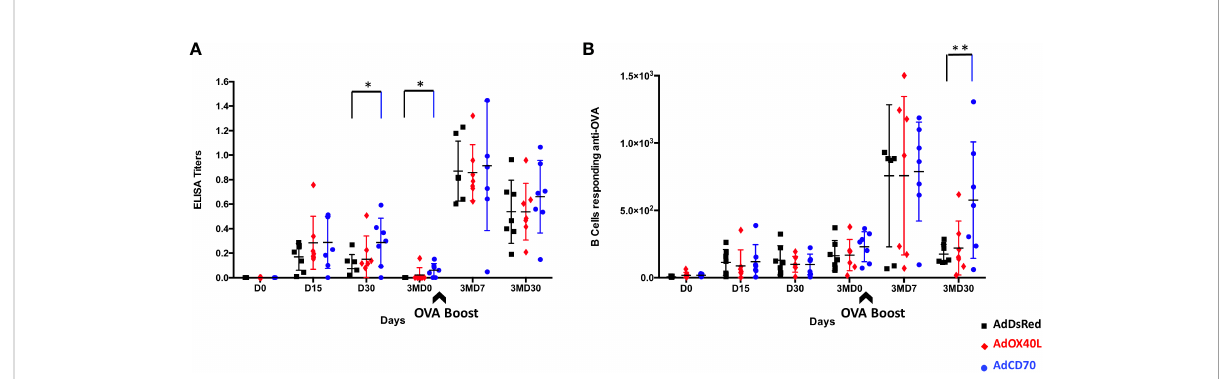
FIGURE 3 OVA speci fi c antibodies production in inoculated sheep. (A) Detection of anti-OVA-speci fi c antibodies by ELISA assay. Inoculation with OVA concomitantly with recombinant adenovirus expressing the Oa OX40L or Oa CD70 proteins induces OVA-speci fi c IgG in sheep. Groups (n = 7) of sheep were inoculated intramuscularly with OVA simultaneously with control vector AdDsRed (black), AdOX40L (red), or AdCD70 (blue), respectively, at day 0; and 3 months later (3MD0) boosted only with OVA (indicated by the arrow). At the indicated time points, the serum samples obtained were analyzed for OVA-speci fi c IgG by ELISA using OVA-coated plates. Data are presented as OD read at 450nm IgG titer for each animal. *p < 0.05 days 30 and 3MD0 AdCD70 inoculated sheep vs. AdDsRed inoculated sheep the same days, respectively (one-way ANOVA). (B) Detection of anti-OVA-speci fi c IgGs-secreting B cells by ELISPOT assay. PBMCs from sheep inoculated with AdDsRed (black), AdOX40L (red), or AdCD70 (blue) and OVA were isolated at the different showed time points and cultured for 48 h on OVA-coated plates. The